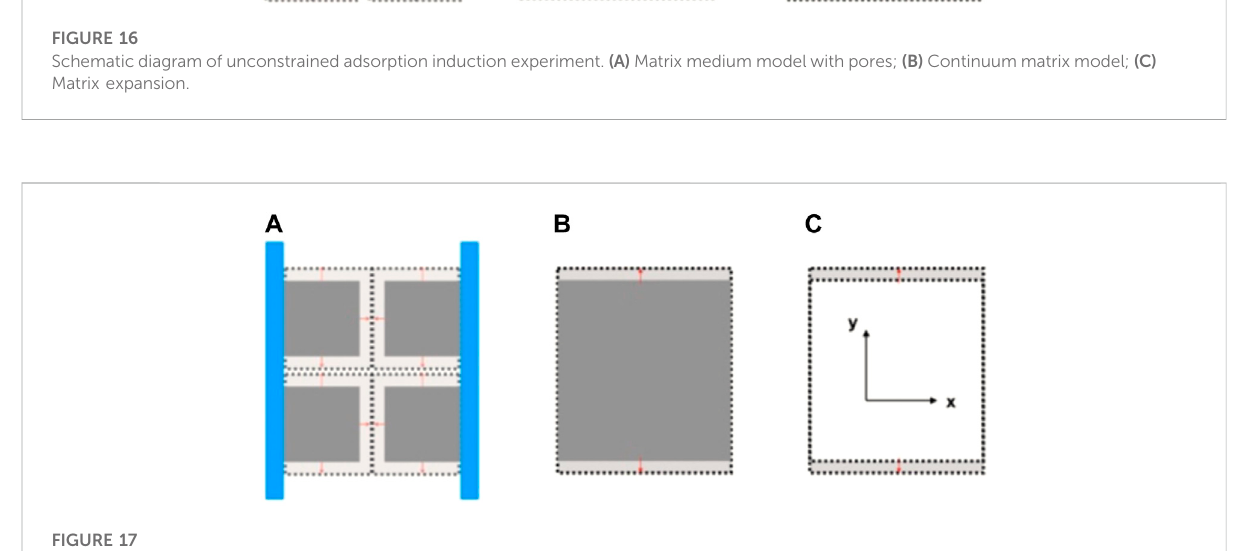
FIGURE 17 X -axis displacement-constrained adsorption induced strain experiment schematic diagram. (A) Matrix medium model with pores; (B) Continuum matrix model; (C) Matrix